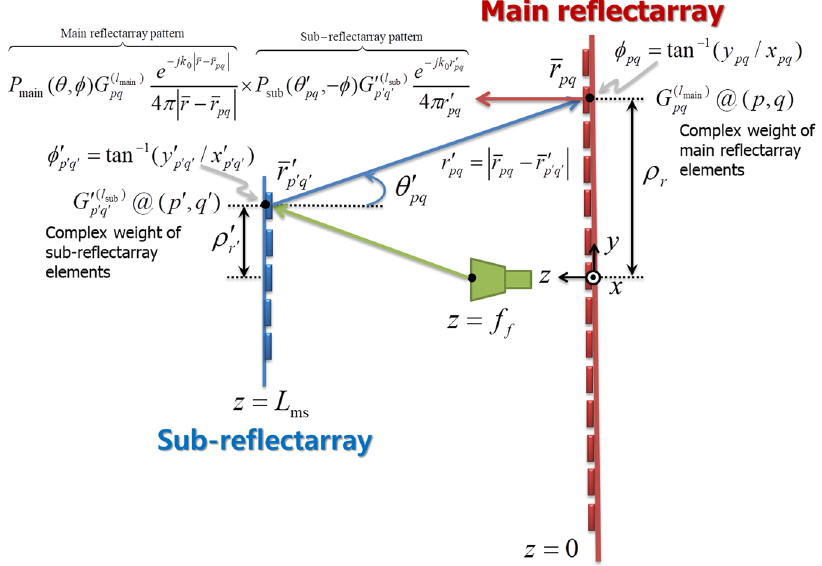
Figure 2. OAM mode-combining mechanism of a Cassegrain dual-reflectarray configuration composed of main and sub-reflectarrays excited by a feed. We set the complex weights of the main and sub-reflectarray elements at the array positions, ( p , q ) and p q ( , ) ′ ′ , to = ψ G Supplementary Derivation of Equations (1) and